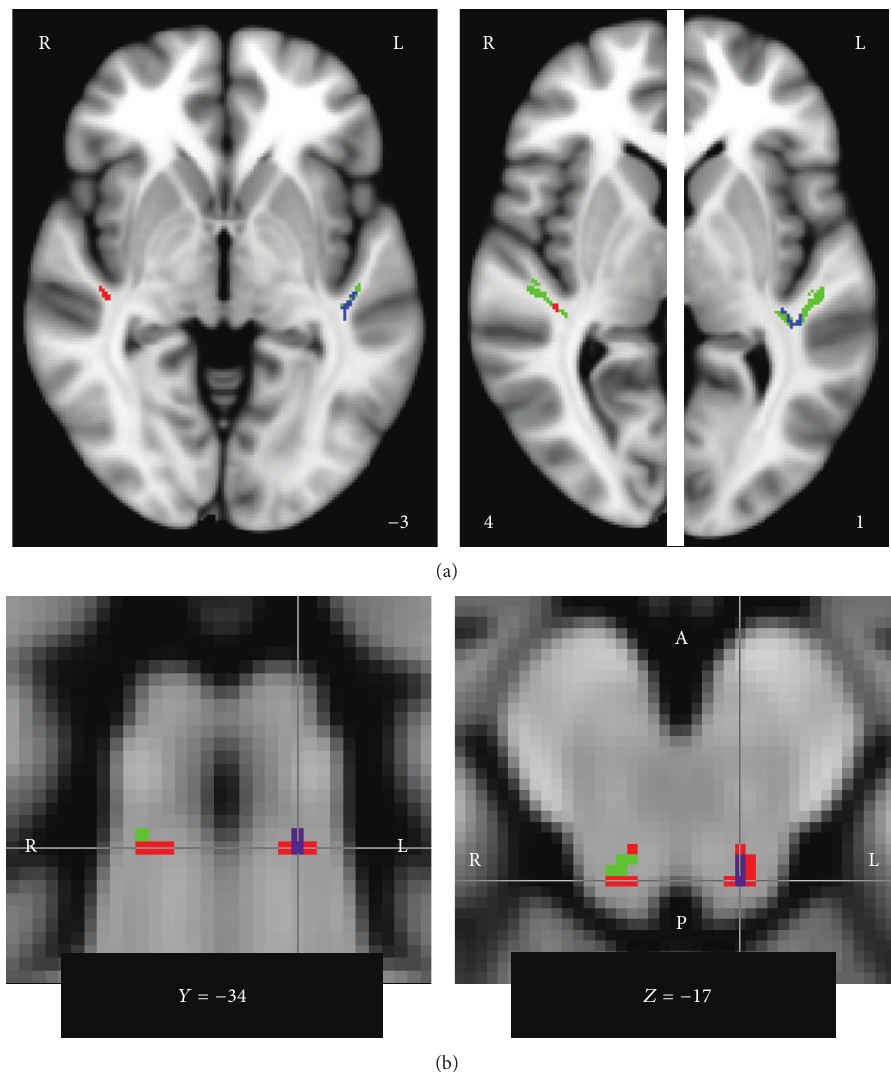
Figure 3: Group differences regarding FA and MD in auditory ROIs. (a) Compared to controls, tinnitus patients showed significantly increased FA (red) in right ACx and significantly decreased MD (blue) in left ACx, with corresponding but nonsignificant trends in the opposite hemisphere.TheROIsareindicatedingreen,andthenumbersattheloweredgesoftheimagesindicatetheMNI 𝑧 -coordinateoftheillustrated horizontal slice. (b) Tinnitus patients also showed significantly increased FA (red) in the WM underneath left and right IC and significantly decreased MD (blue) in the WM underneath left IC; a corresponding trend was also present in right IC. Voxels for which both FA increases and MD increases were significant are shown in purple. The numbers at the lower edges of the images indicate the MNI coordinate of the illustrated coronal/horizontal